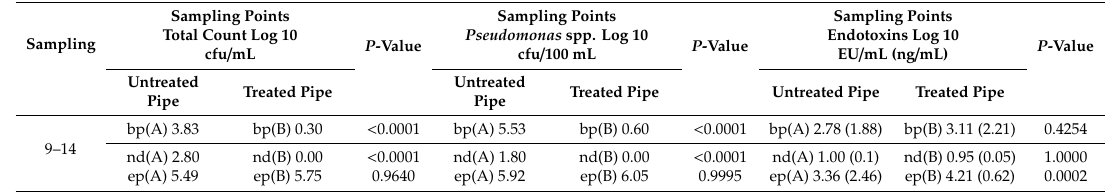
Table 3. Results from compartment B (treated pipe) and compartment A (control pipe).